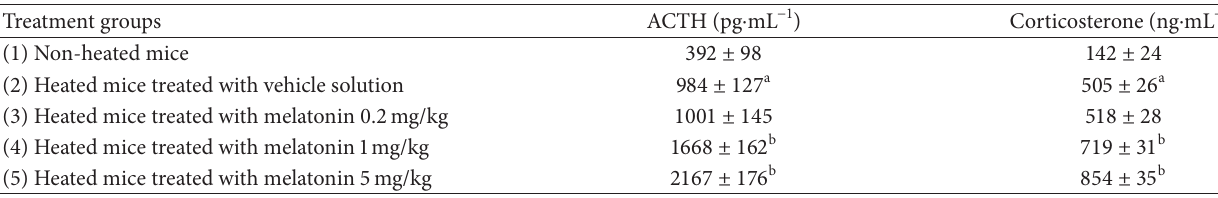
Table 6: Effect of heat exposure on serum levels of adrenocorticotrophic-hormone (ACTH) and corticosterone in different groups of mice. Treatment groups ACTH (pg ⋅ mL − 1 ) Corticosterone (ng ⋅ mL − 1 ) 392 ±